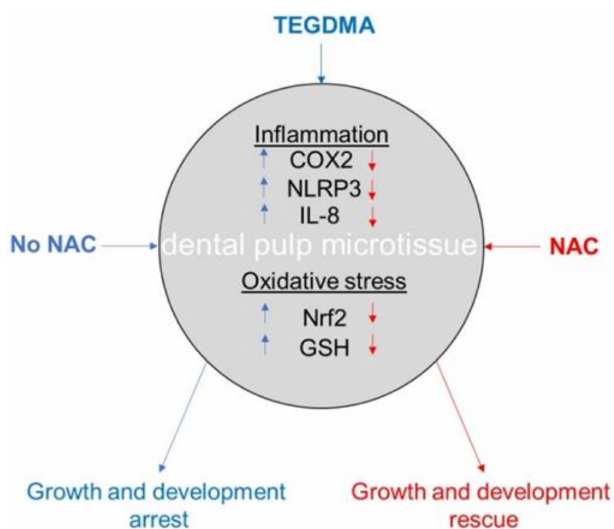
Figure 7. Schematic diagram recapitulates the impact of TEGDMA exposure and NAC treatment on inflammatory and oxidative stress responses of growth-arrested versus resumed (rescued) dental pulp microtissue a ff ected by toxic dental resin monomer. Arrow pointing up and down indicates an increase and decrease in protein levels,